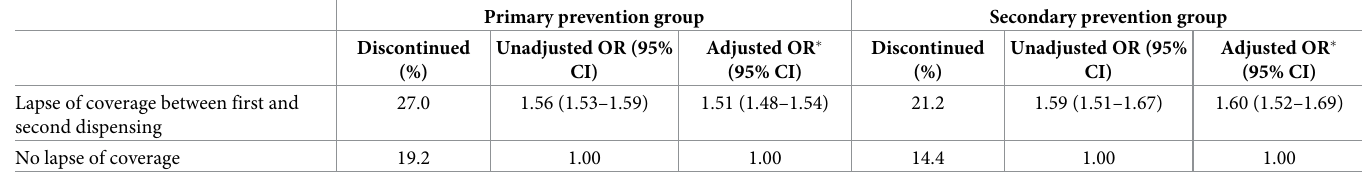
Table 5. Impact of a lapse of coverage between the first and second statin dispensing on odds of subsequent discontinuation of